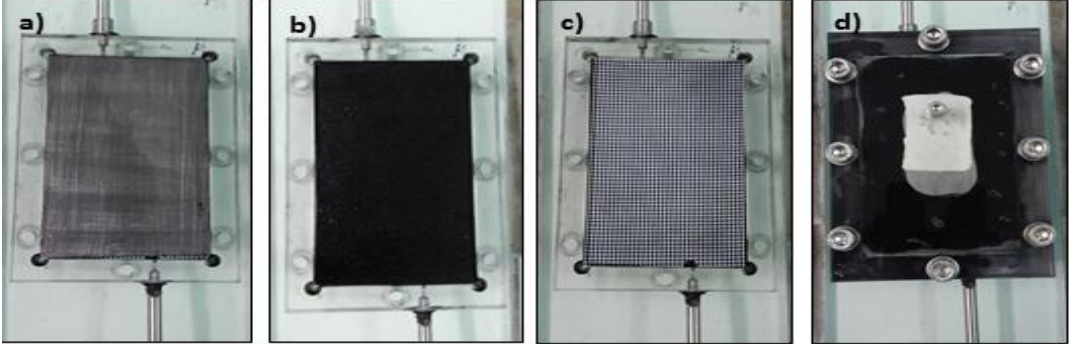
Figure2. CDI,( a )Opencellwithacurrentcollector, ( b )currentcollectorwithelectrode, ( c )solidelectrode Figure 2. CDI, ( a ) Open cell with a current collector, ( b ) current collector with electrode, ( c ) solid with a separator, ( d ) closed electrode with a separator, ( d ) closed cell.